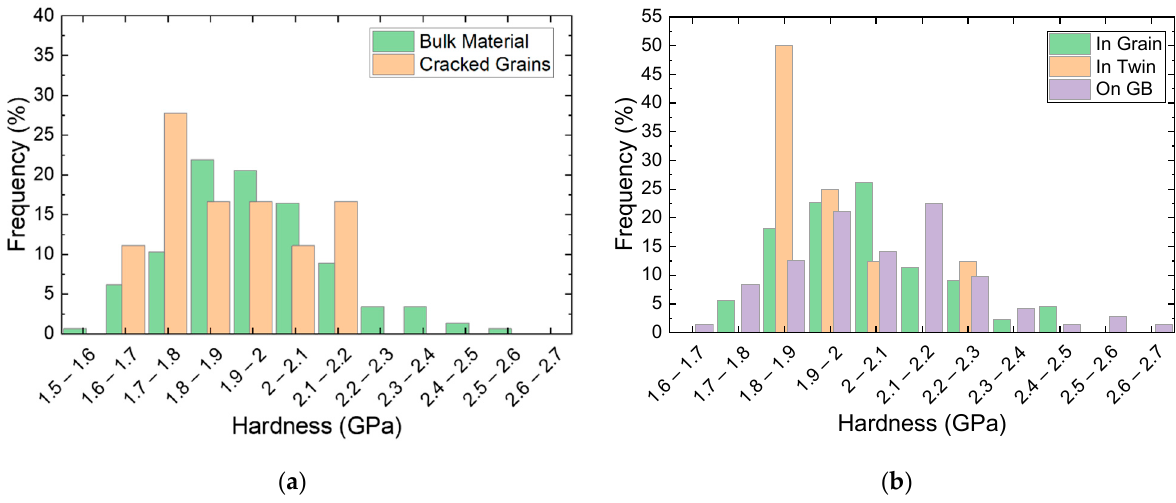
Figure 5. Hardness distribution of ( a ) cracked grains on crack path compared to bulk uncracked material, and ( b ) indents located within grains, within twins, and on GBs.